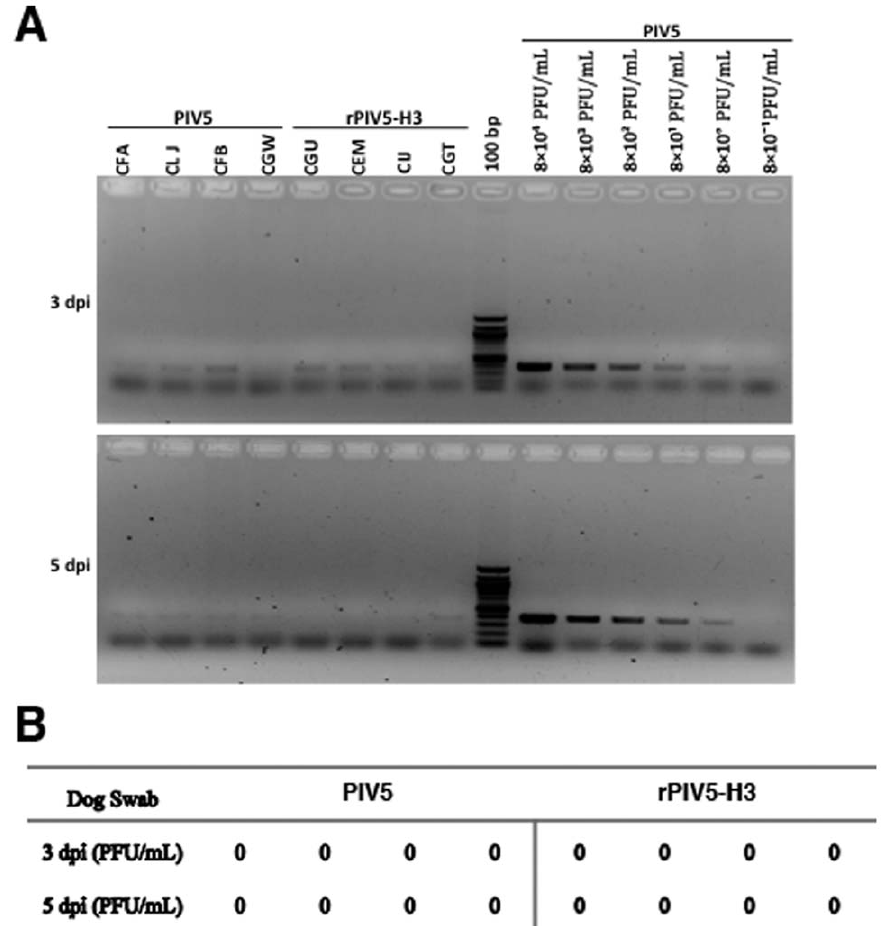
Figure 2. Replication of PIV5 in dogs without PIV5 exposure. The nasal swabs of dogs were collected at 3 and 5 days post infection, and placed into a vial containing 0.5 mL of DMEM with 2% FBS. (A) Detection of virus with RT-PCR. (B) Detection of virus with plaque assay. Swab samples were examined by plaque assay on BHK21 cells. Two replicates for each serially diluted swab sample (1:10 0 to 1:10 2 ) were used in the assay.